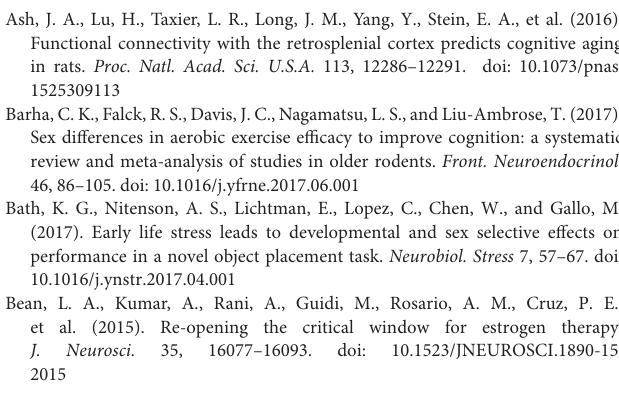
FIGURE S1 | The top panels illustrate the three-dimensional functional connectivity maps of females ( n = 10) and male ( n = 10) rats. The lower graphs illustrate no sex difference in global network connectivity. (A) Symbols represent mean ( ± SEM) for small world coefficient (left), clustering coefficient (center), and path length (right) over the graph density thresholds for females (filled circle) and male (open square) animals. FIGURE S2 | A mean split of the 12-month average savings scores was used to classify animals as impaired and unimpaired. The top panels illustrate the three-dimensional functional connectivity maps of the impaired (left) and unimpaired (right) performers. The lower graphs illustrate no difference in global network connectivity associated with cognitive function at 12 months. (A) Symbols represent mean ( ± SEM) for small world coefficient (left), clustering coefficient (center), and path length (right) over the graph density thresholds for impaired (filled circle) and unimpaired (open square)